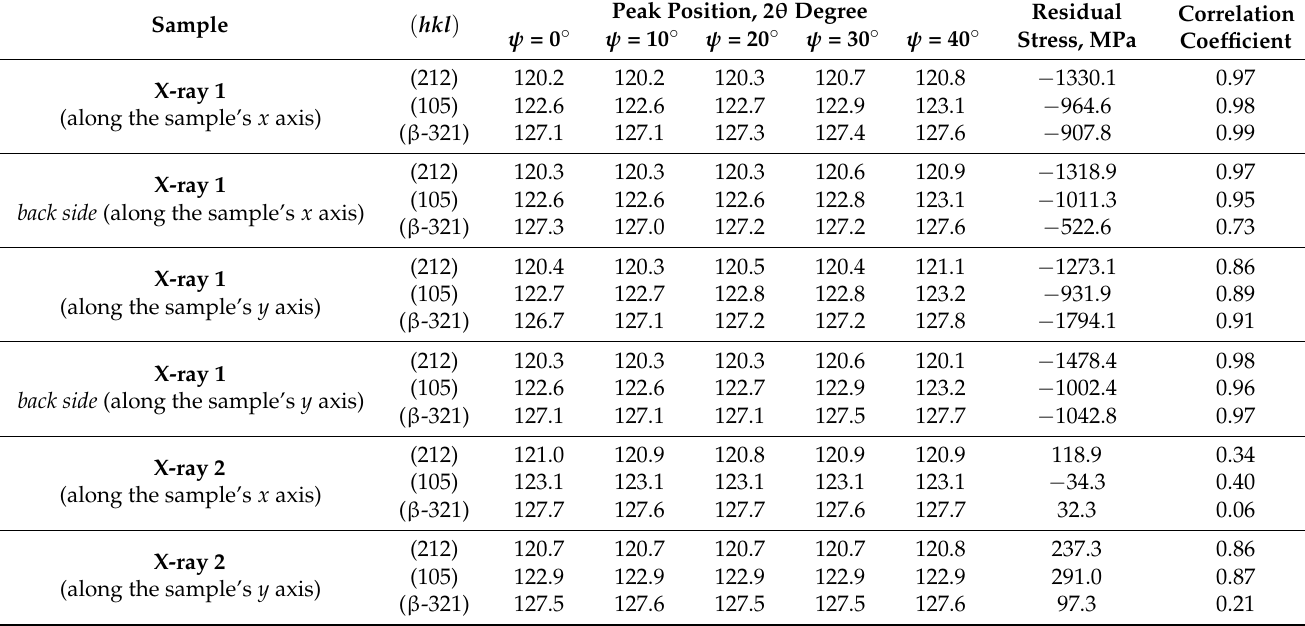
Table 1. Residual stresses in X-ray 1 (shot peening) and X-ray 2 (non-treated) specimens of VT6. The estimations of the residual stress for correlation coefficient below 0.85 (absolute value) are given in Italic